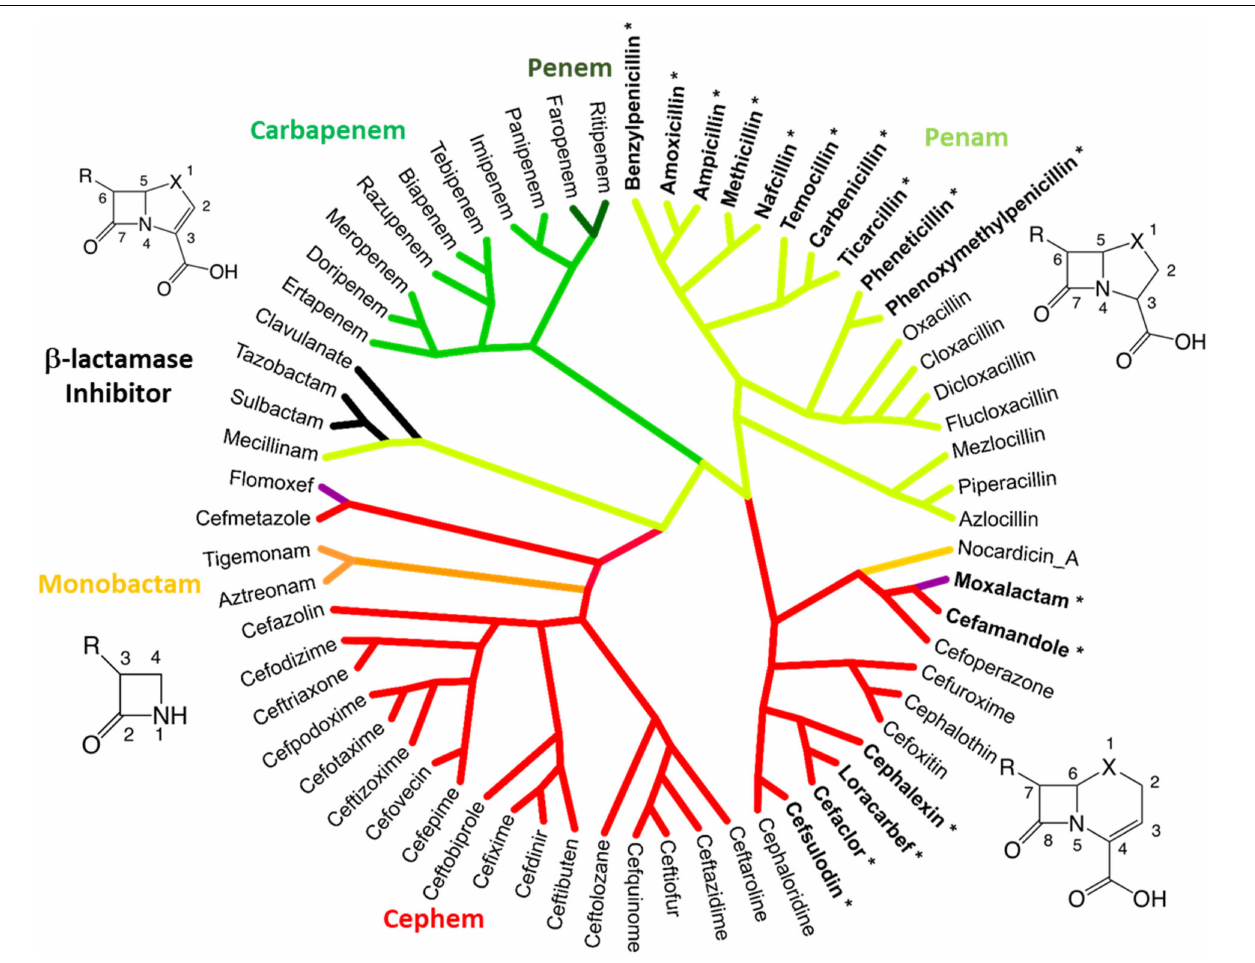
FIGURE 4 | The Lactamome: Radial chemogram of major β -lactams by chemical similarity. Clustering used hierarchical complete linkage MAACS-keyed Tanimoto coefficient. Clustering was performed using ChemMine and visualized using Dendroscope (Huson et al., 2007; Backman et al., 2011). Colors indicate major chemotypes. Note that the oxacephems: moxalactam and flomoxef, are colored purple. Bolded lactams marked with an asterisk indicate drugs with high allergy potential ( > 10%) relating to the R 1 benzyl